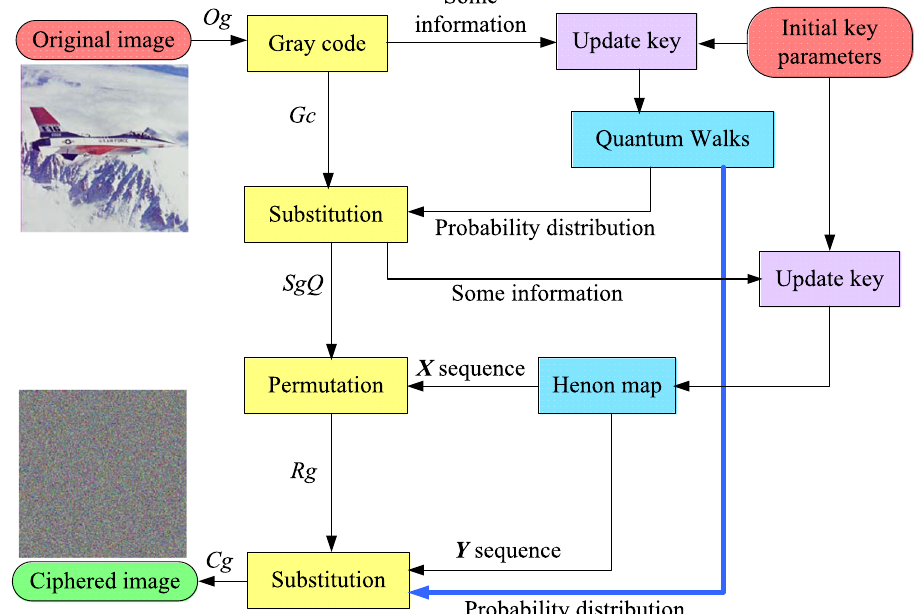
Fig.1 Frameworkforviablequantumcryptographicmodelondigitaldevicesforsecuringdatastoredincloudstoragestoachievedataconfidentiality and privacy through and after the transformation stage to the quantum age Fig. 2 Outline of the proposed encryption